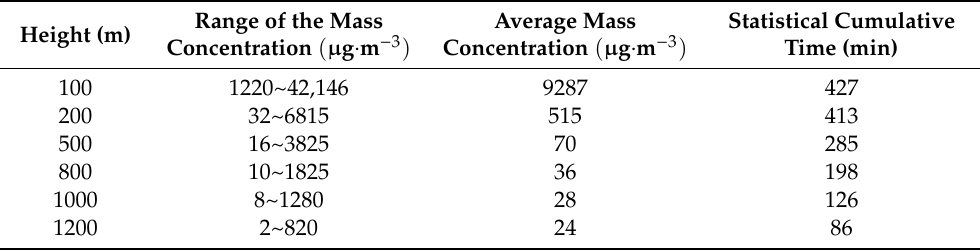
Table 5. The distribution features of dust mass concentration at di ff erent heights during the dust storm period.